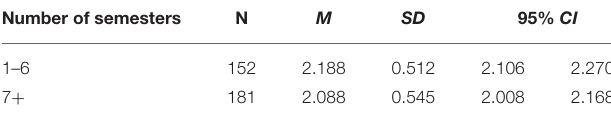
TABLE 5 | Descriptive statistics for social distance score as function of number of semesters.